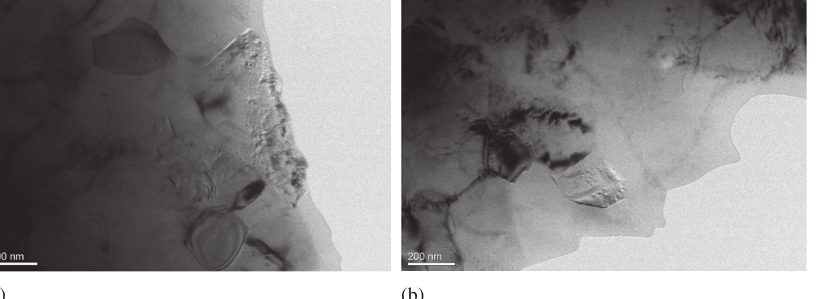
Figure 8: TEM image showing dislocation density between particles and matrix of specimen laser-melted under (a) air and (b) liquid nitrogen.